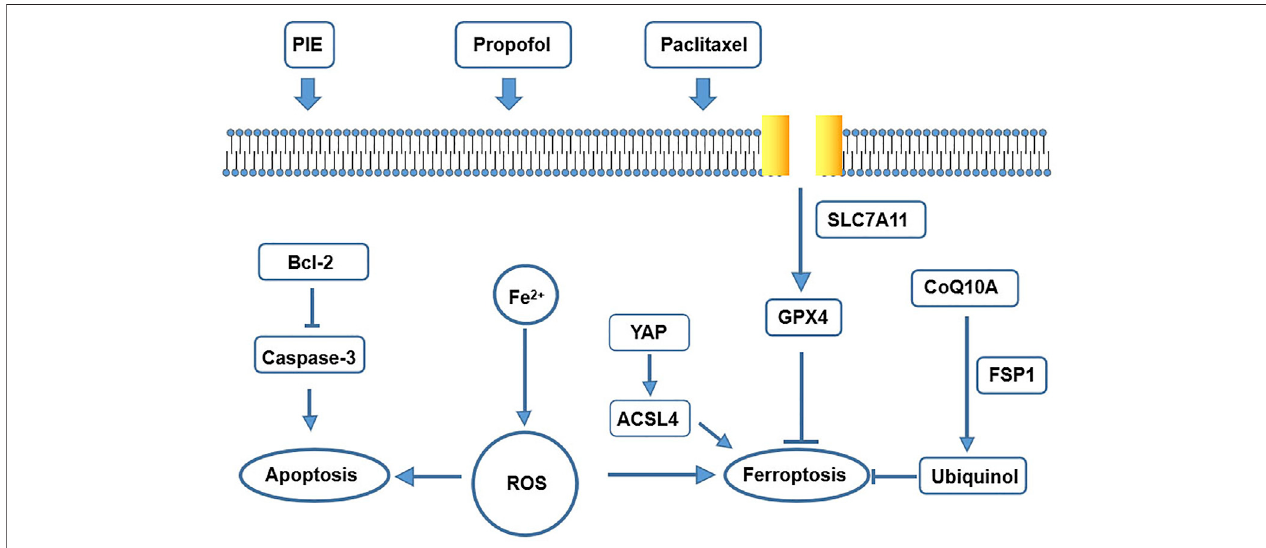
FIGURE 7 | A schematic map of potential mechanisms for drug treatment leading to apoptosis and ferroptosis in our study.